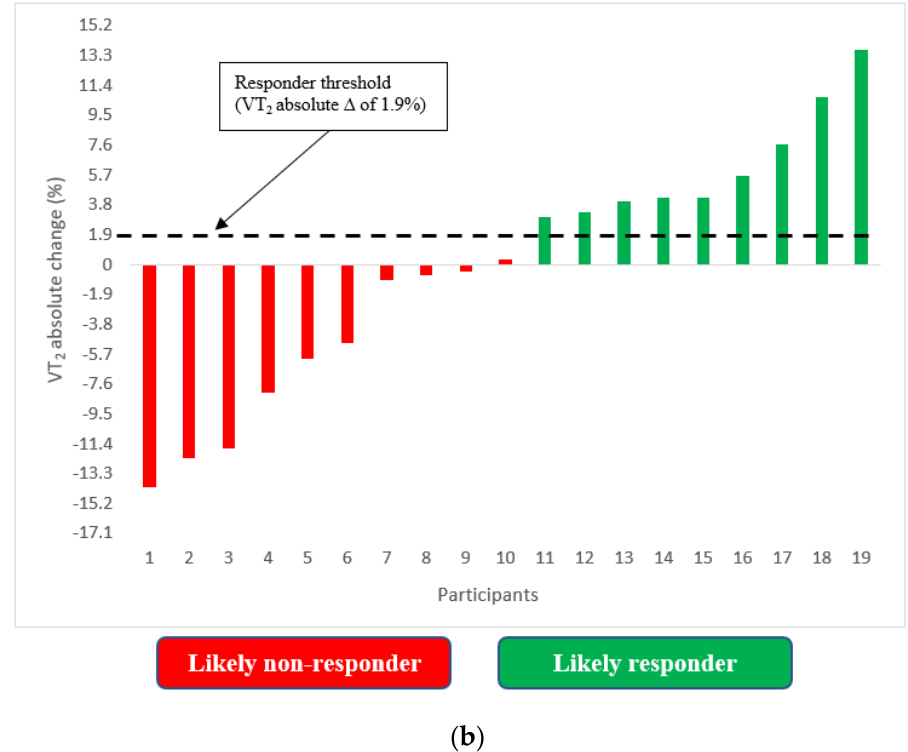
Figure 3. VT 2 absolute change post individualised ( a ) and standardised ( b ) exercise intervention.